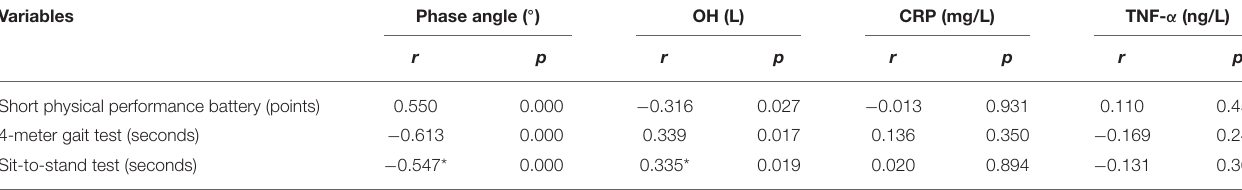
TABLE 4 | Correlations between bioimpedance parameters and physical function tests in patients on peritoneal dialysis ( n = 49). Variables